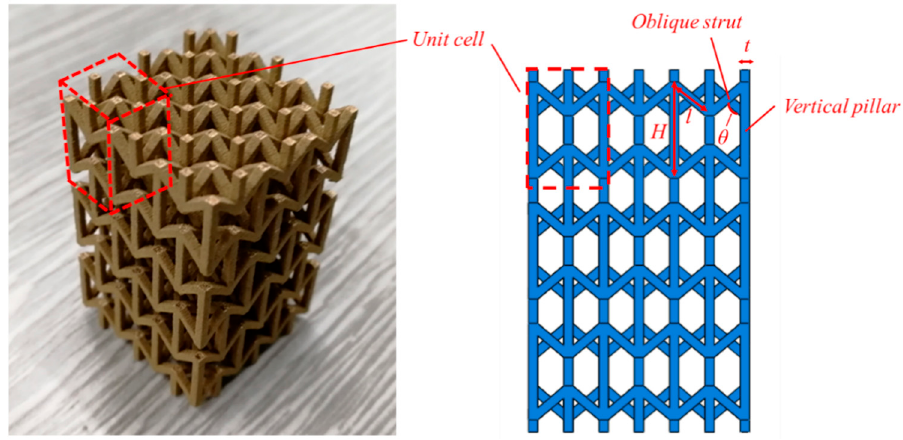
Figure 1. 3D auxetic structure.